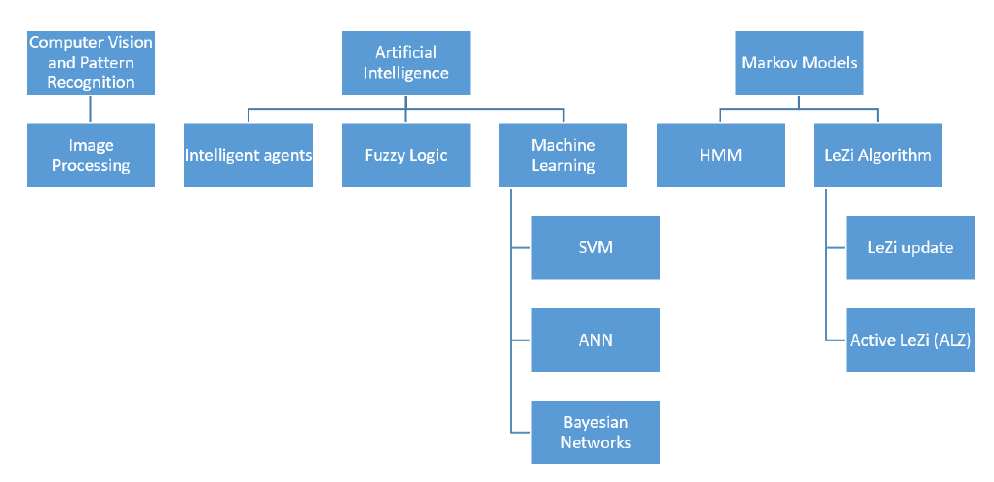
Figure 3. Analysis